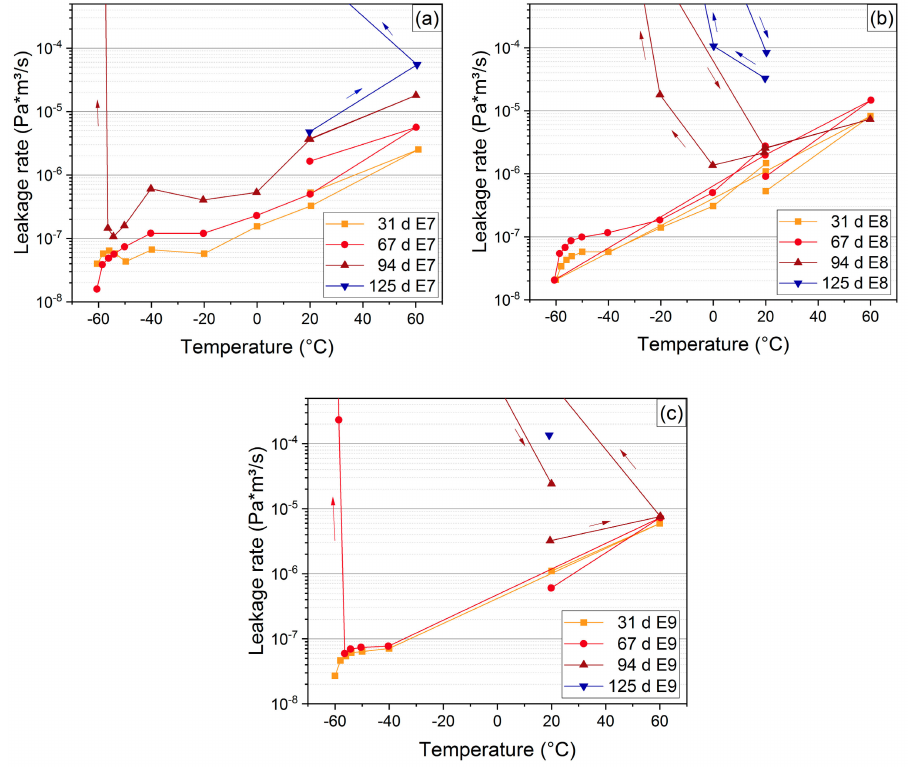
Figure 16. Measured leakage rates vs. temperature for lubricated EPDM seals E7 ( a ), E8 ( b ), and E9 ( c ) at 150 ◦ C. The arrows indicate the temperature sequence (cf. Table